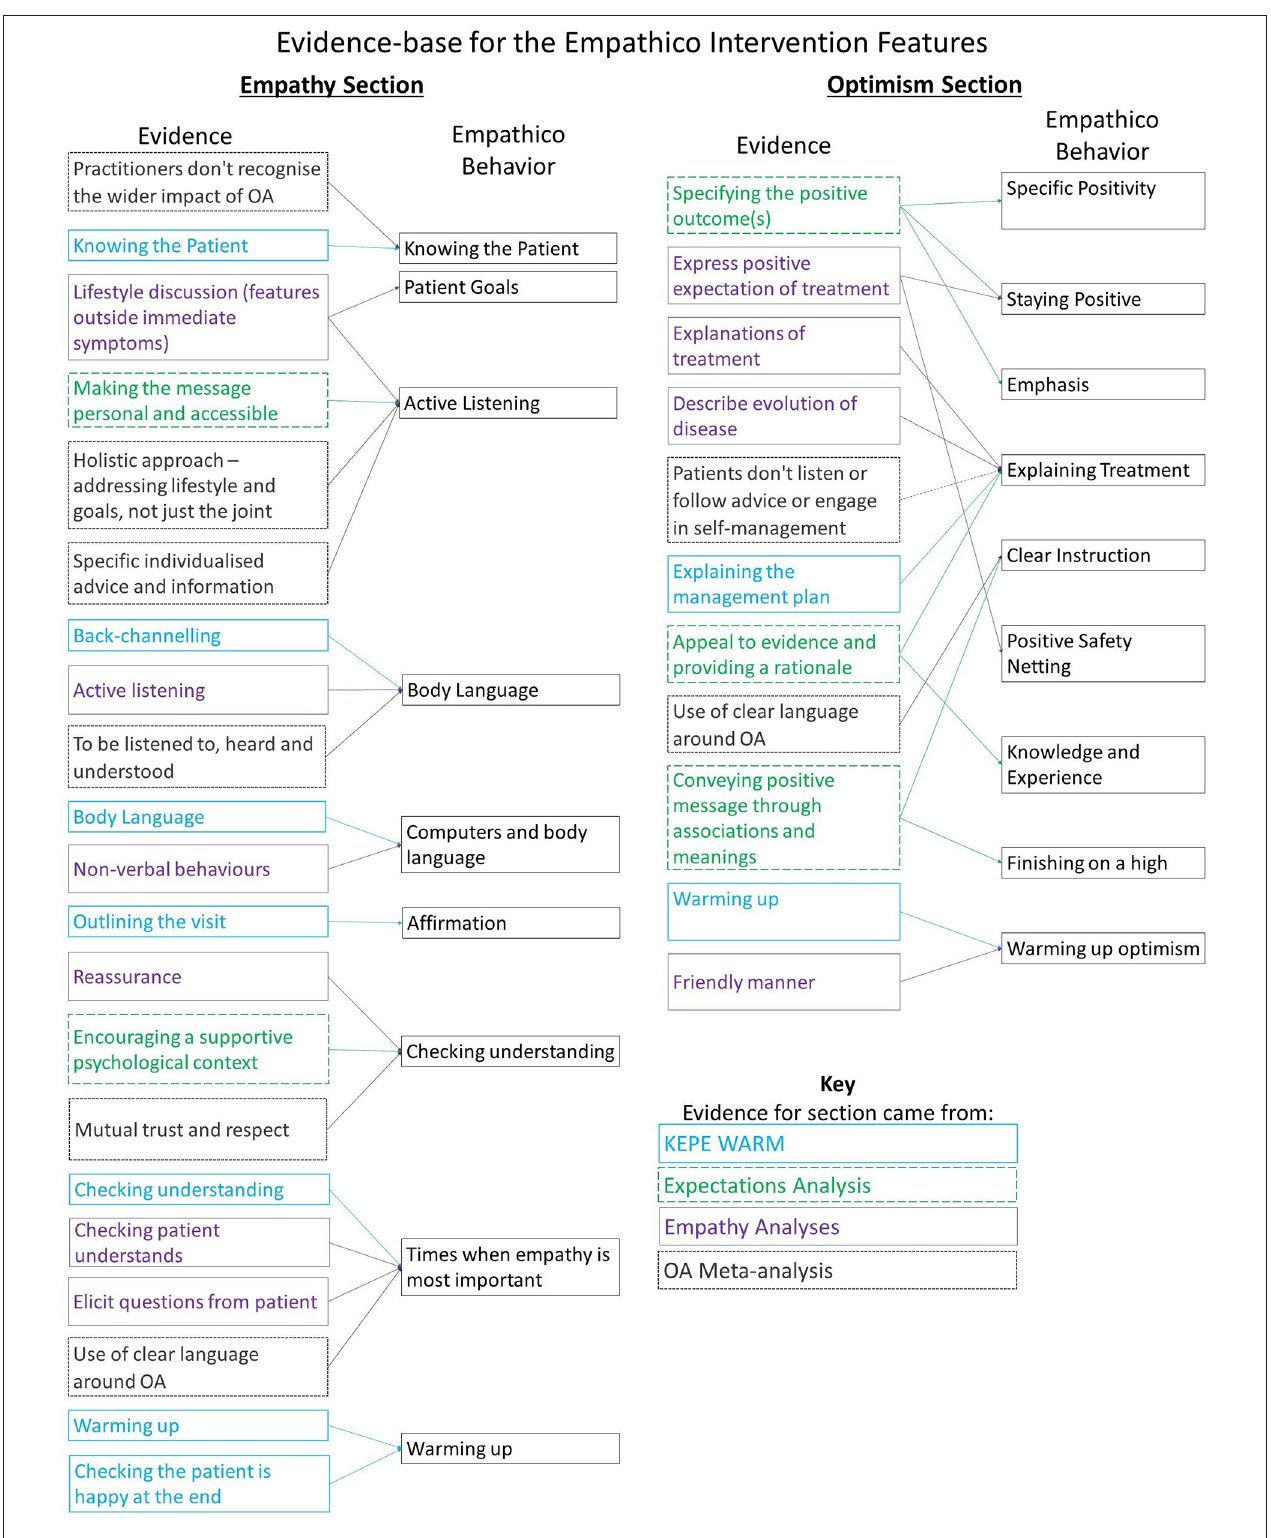
FIGURE 2 | The evidence-base for the planned contents of Empathico training on clinical empathy and realistic optimism.